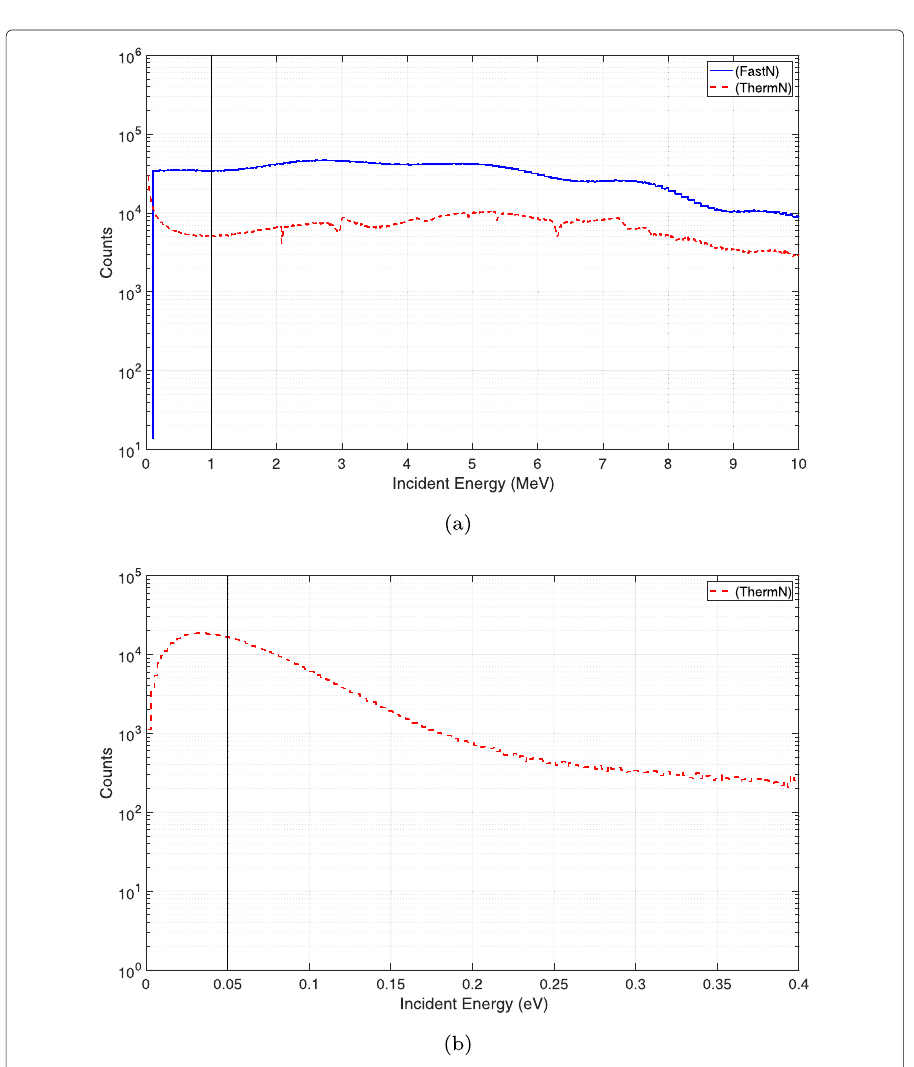
Fig. 8 a Incident neutron energy in the detector active area for configurations (FastN) and (ThermN). The energy range 0-10 MeV is the 238 Pu/Be source emission spectrum. b The counts in 0 < E n < 0.4 eV are shown. The vertical lines represent the cut at the E 2 = 1 MeV and E 2 = 0.050 eV used to calculate the fast and thermal flux